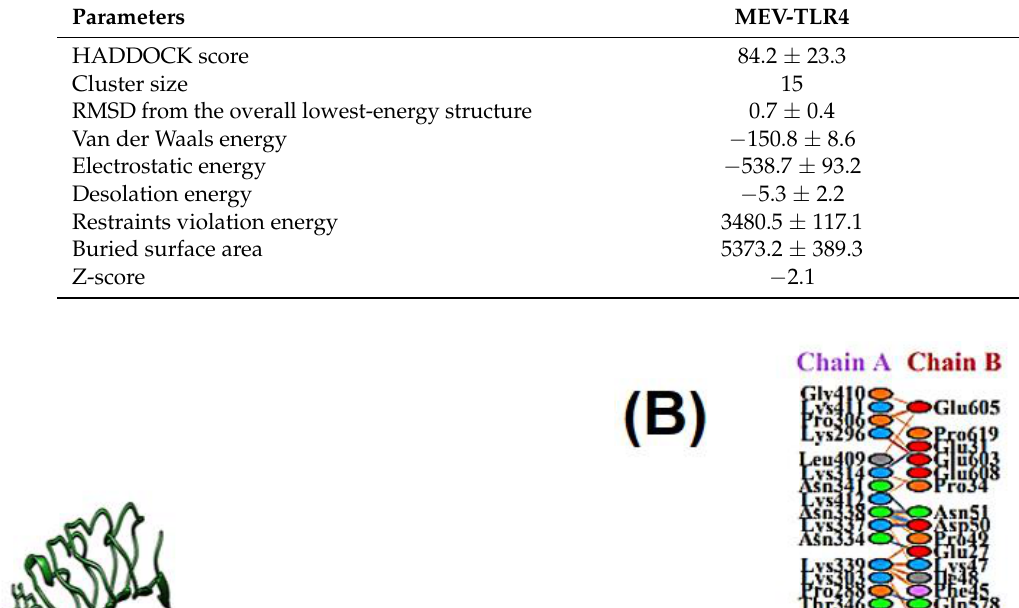
Table 4. Details of docking complex TLR-4 with MEV.